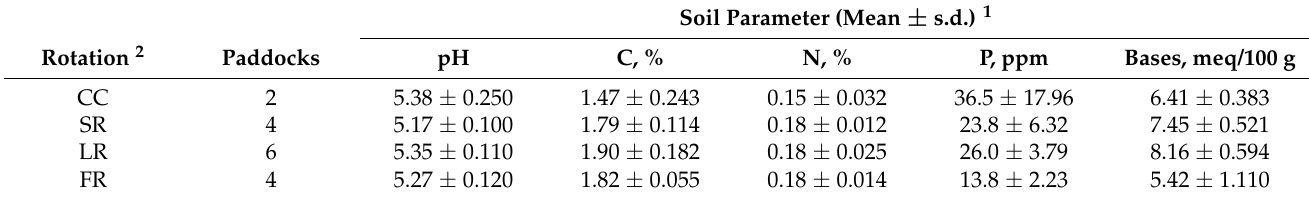
Table 2. Soil properties (0–15 cm) in the ‘Palo a Pique’ pasture–crop rotations long-term experiment in Treinta y Tres, Uruguay (2019). Soil Parameter (Mean ± s.d.) 1